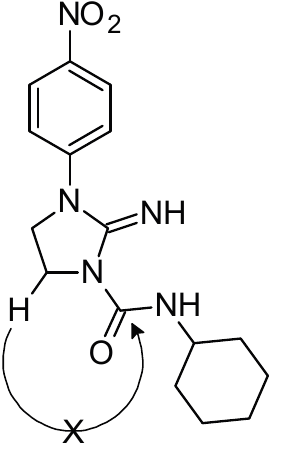
Figure 1. HMBC spectrum of compound 4f shows absence of expected three-bond correlation between methylene hydrogens H4 and carbonyl carbon C7.